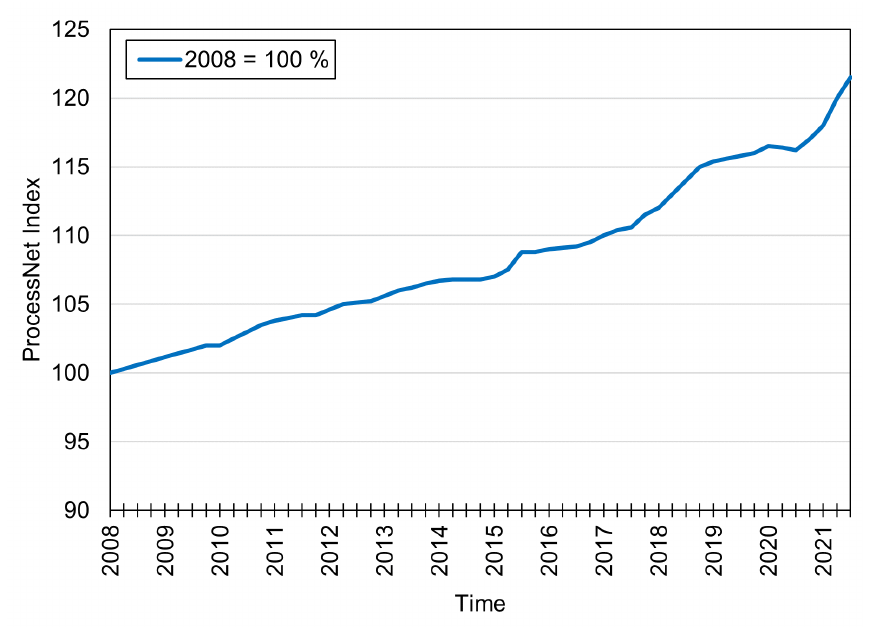
Figure A1. Quarterly development of the ProcessNet—Chemical Plant Price Index Germany since